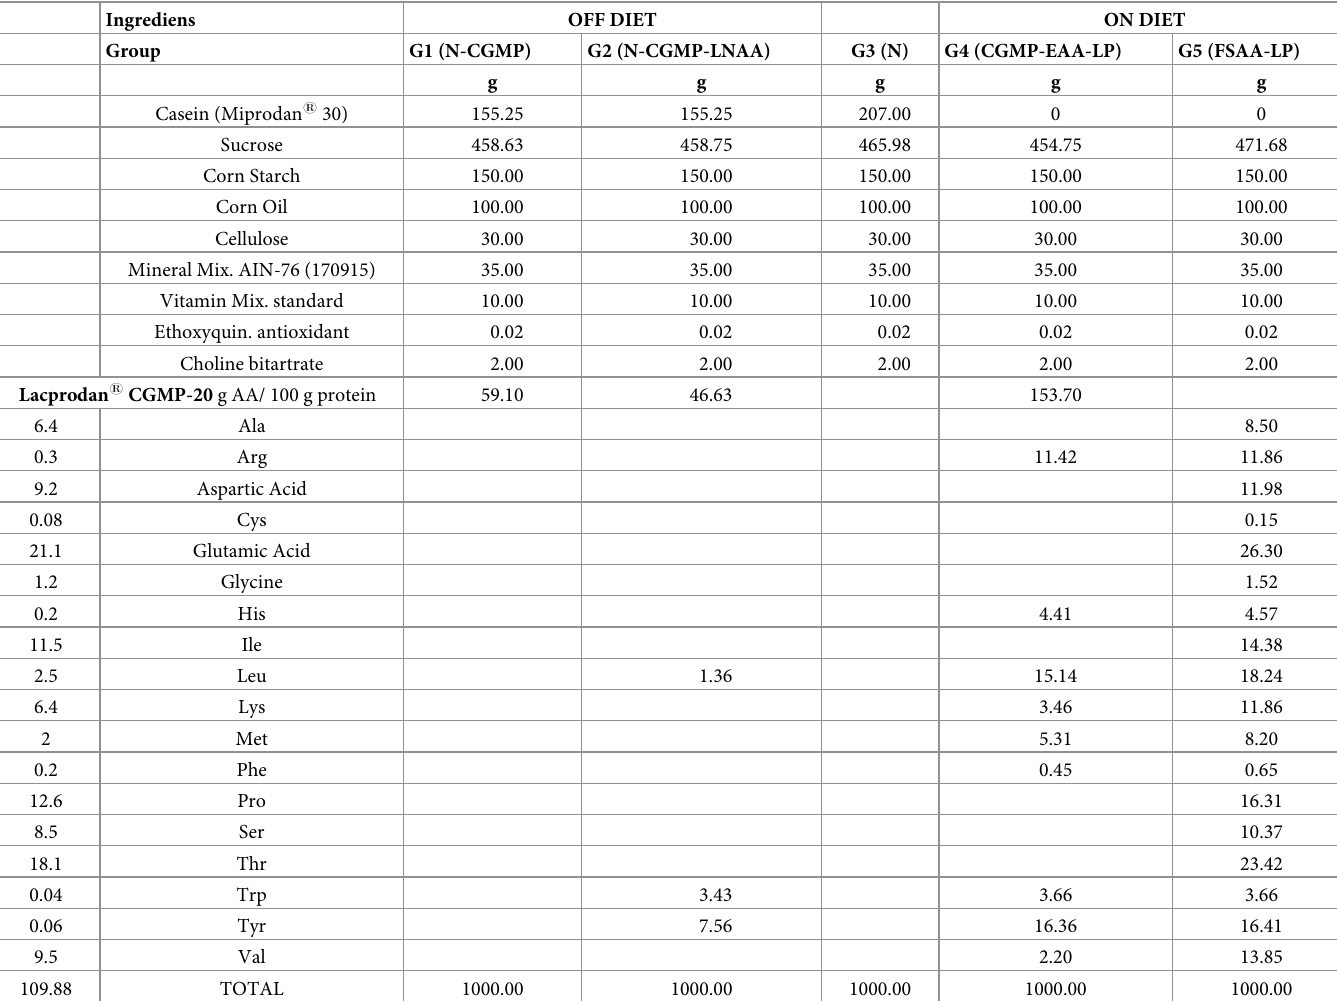
The composition is based on the following recommendation: WHO Technical Report Series. Protein and amino acid requirements in human nutrition. 2007 [28]. See also Table 2. � G1-G5 refers to groups 1–5. In addition to CGMP, G2 and G4 received additional AA in form of FSAA (% indicates fraction of AA received in the form of FSAA): Off diet (G2): Leu: 53.75%, Trp: 99.42% and Tyr: 99.6%. On diet (G4): Arg: 96.25%, His: 93.44%, Leu: 79.76%, Lys: 30.42%, Met: 64.60%, Trp: 98.36%, Tyr: 99.44% and